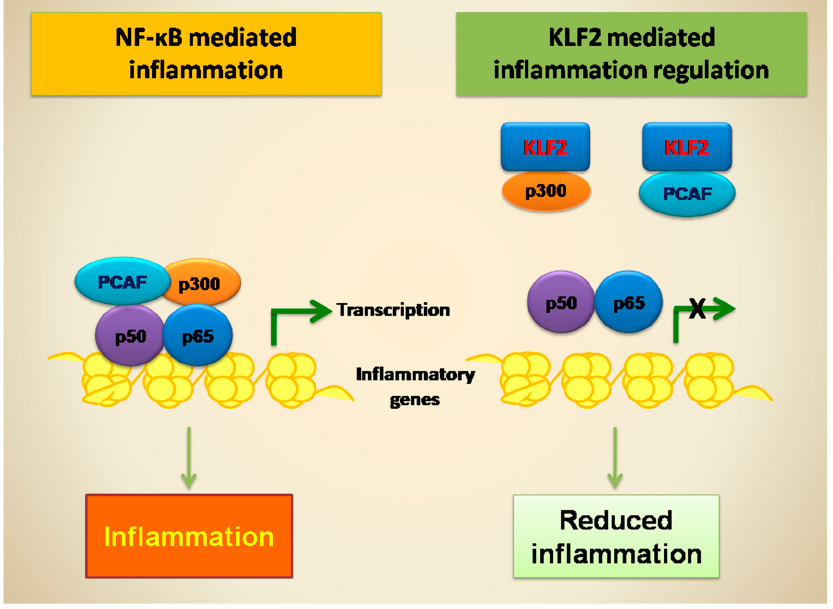
Figure 2. NF- κ B and KLF2 in transcriptional regulation. PCAF: p300/cyclic adenosine monophosphate response element binding protein (CBP)-associated factor.